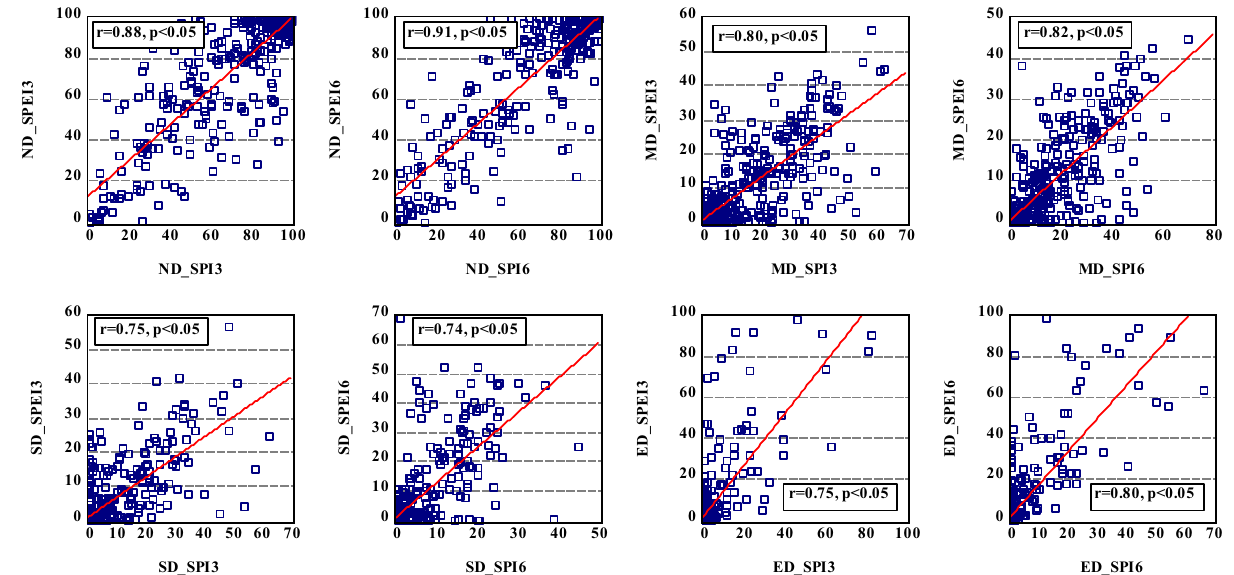
Figure 8. Spatial extant (%) correlation between same agricultural drought classes for SPI and SPEI between 1961 and 2010 (figure was generated using EViews (https:// www. eviews. com/ home. html)).